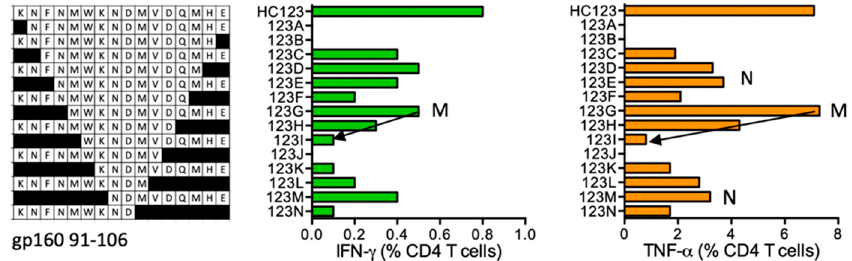
Figure 14. HC123 / VID 420—definition of CD4 + T-cell epitopes in HIV-1 protein glycoprotein gp160. HC123-expanded PBMCs from subject 420 were tested in ICS against shorter peptides (left) and CD4 + T cells producing IFN- γ (green) and TNF- α (orange) were enumerated. Arrows and amino acids M and N indicate the stimulatory peptide termini.